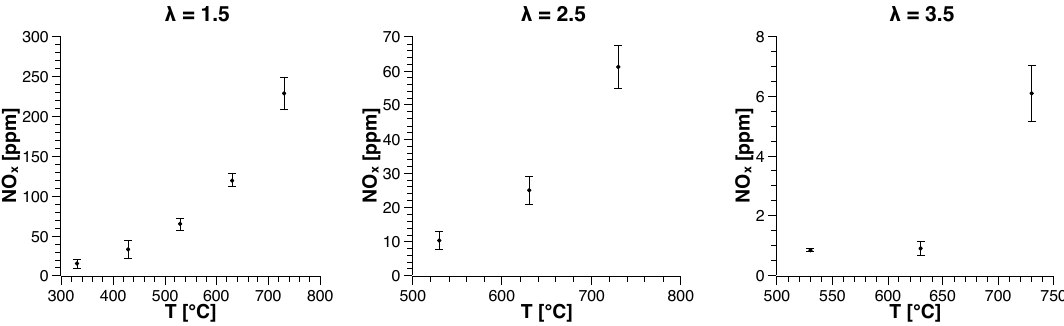
Figure 9. NO x concentration (ppm) in the exhaust gases, normalized at 15% O 2 , as a function of the air inlet temperature for different values of the air-to-fuel ratio λ